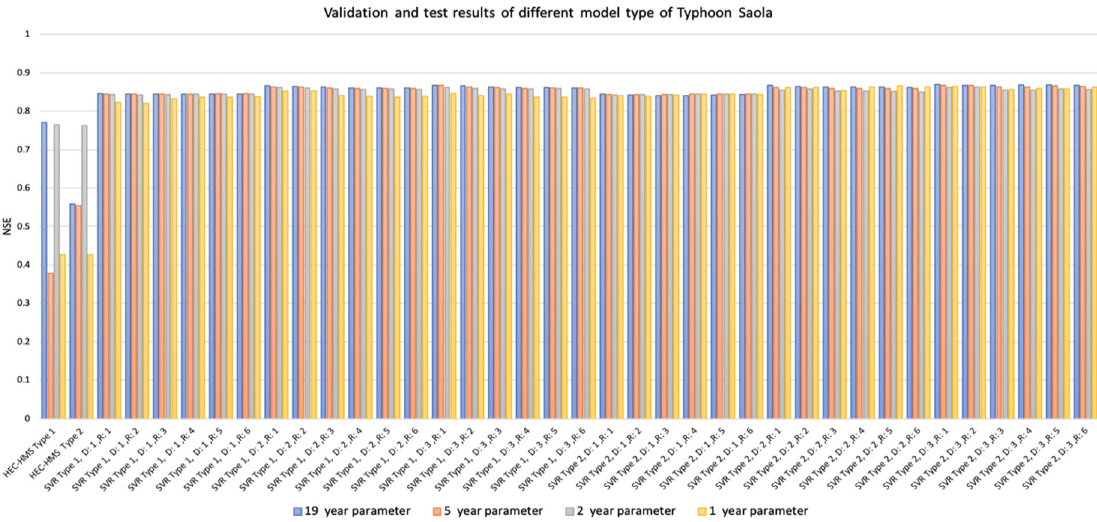
Table 7. Parameter optimization results of the HEC-HMS of the study events.